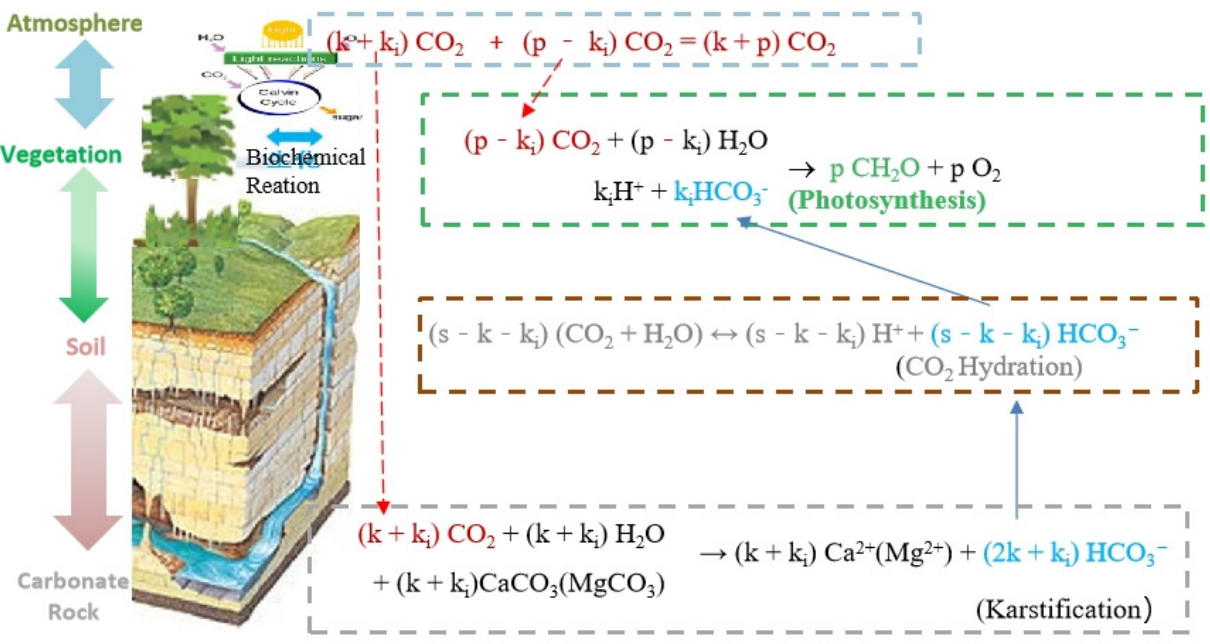
Figure 2. The determination principle of karstification, photosynthesis, and net karst carbon sink under karstification–photosynthesis coupling (example uses are terrestrial plants; aquatic plants replace soil with water bodies), where ki is the amount of root-originated HCO 3 − used by plants, k i /p is the share of plant utilization of root-originated HCO 3 − , k i /(p − k i ) is the stoichiometric ratio of root-originated HCO 3 − and atmospheric CO 2 utilized by plants, p is the photosynthesis of plants, and k + k i is the karstification of carbonate rocks. It should be noted here that from the initial process of carbon sequestration, p − k i is the photosynthetic carbon sink of plants, k + k i is the apparent karst carbon sink of carbonate rocks, s is the carbon sink of soil, and (k + k i )/(p − k i ) is the stoichiometric ratio of karstification and photosynthesis under karstification–photosynthesis coupling. From the substantial process of carbon sequestration, p is the photosynthetic carbon sink of plants, which includes the direct carbon sink p − k i and the indirect carbon sink k i , k + k i is the apparent karst carbon sink of carbonate rock, which includes the apparent karst basic carbon sink k and the intermediate carbon sink k i from karstification–photosynthesis coupling, and k/p is the stoichiometric ratio of karstification and photosynthesis under karstification–photosynthesis coupling. It can also be seen that the karstification–photosynthesis coupling system not only increases the carbon sink of the system as a whole, but also increases the stability of the carbon sink in karst ecosystems, because the photosynthetic carbon sink is more stable than HCO 3 − .